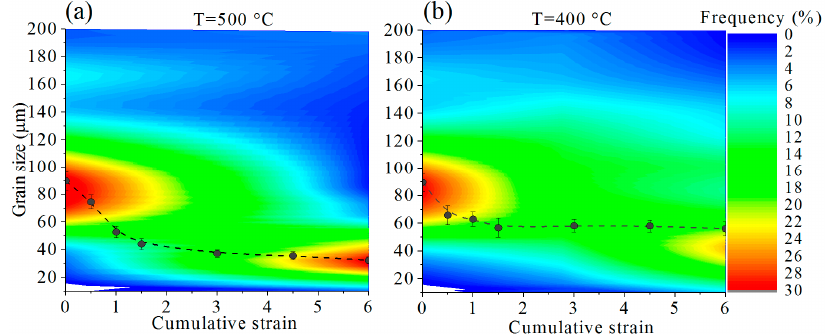
Figure 5. Grain size distribution after IMF process at ( a ) 500 °C and ( b ) 400 °C. Dashed lines show the mean grain size evolution.